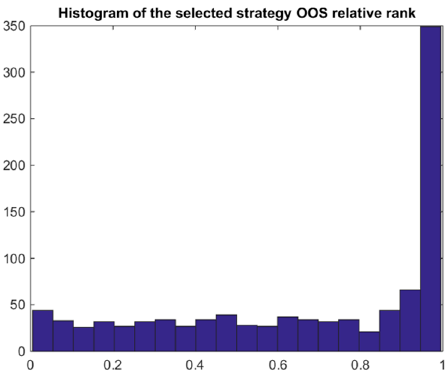
Figure 11. CSCV histogram of the out-of-sample relative rank of the best IS strategy.